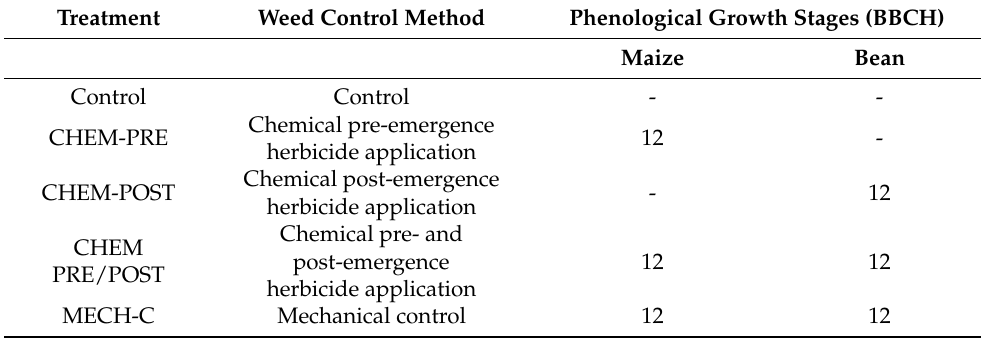
Table 3. Treatments, method of weed control, and phenological growth stages (BBCH) of maize and bean at the treatment